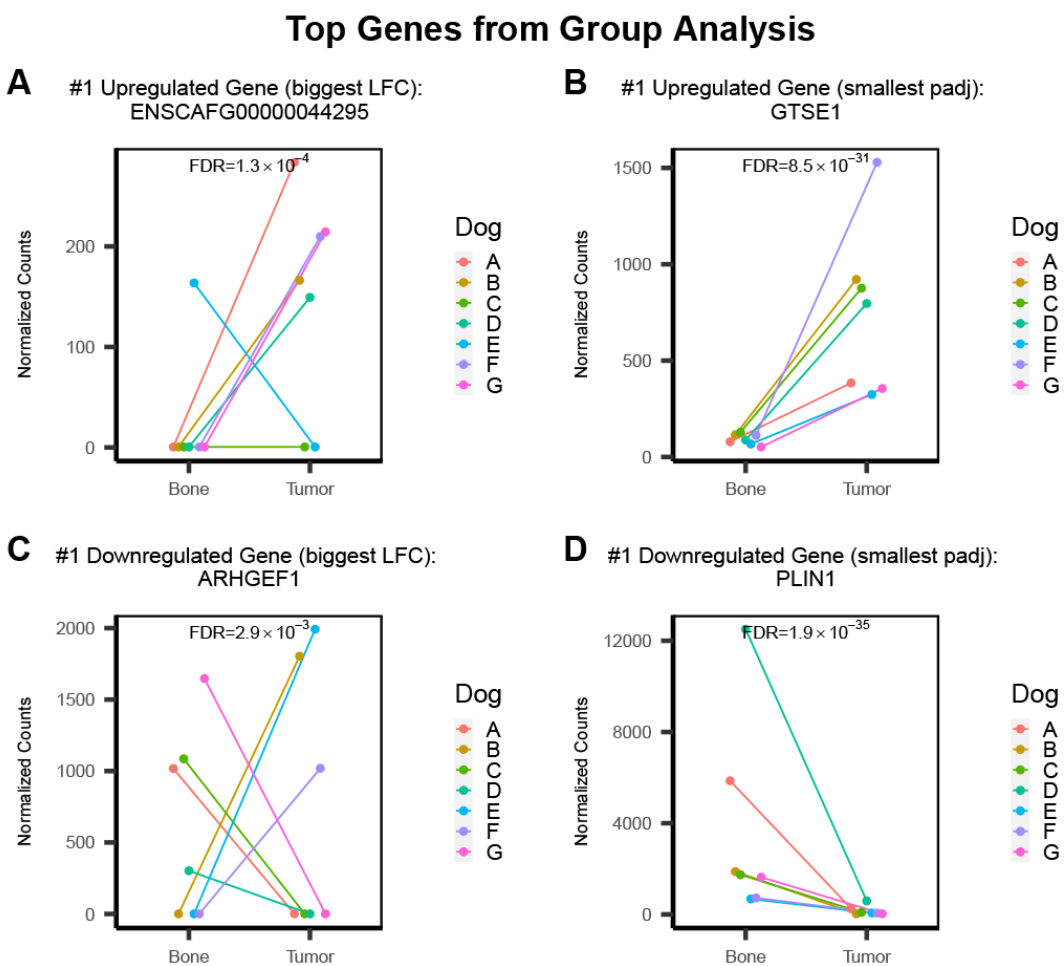
Figure 4. Plots of the normalized counts of the top up- and down-regulated genes in the classical group analysis show some variation among individual patients. The number one gene when or- dered by log2 fold-change shows variation among individual patients ( A , C ). The top gene when ordered by smallest adjusted p -value shows less variation in terms of direction of fold-change, but some variation between individuals is still evident ( B , D